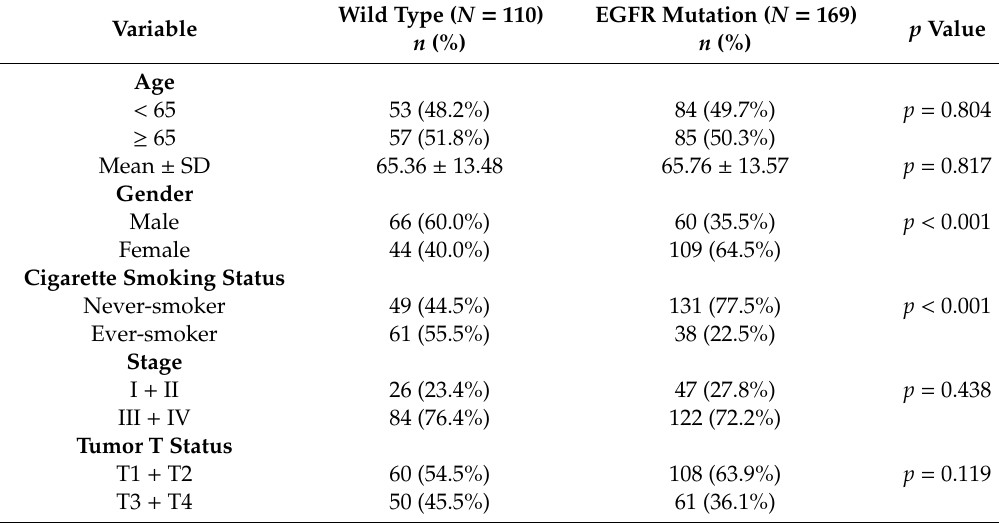
Table 1. Demographics and clinical characteristics of 279 patients in lung adenocarcinoma with the epidermal growth factor receptor (EGFR) mutation